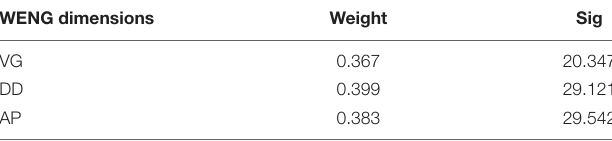
TABLE 2 | Redundancy analysis: weight and significance of dimensions.